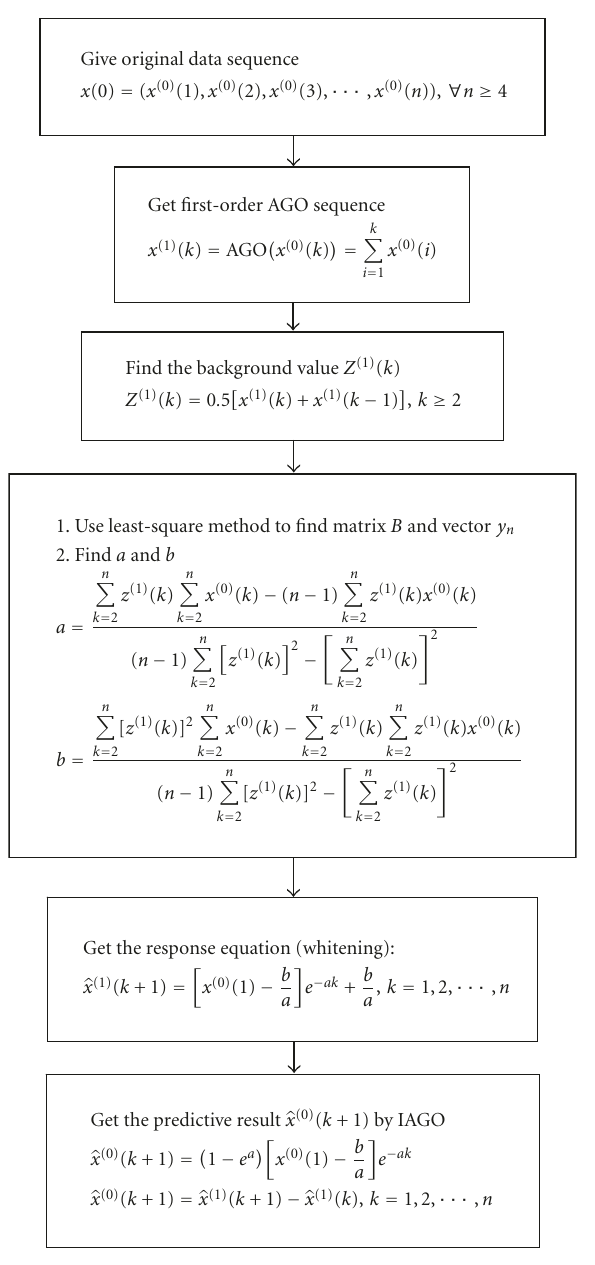
Figure 6: The flowchart of grey model construction.